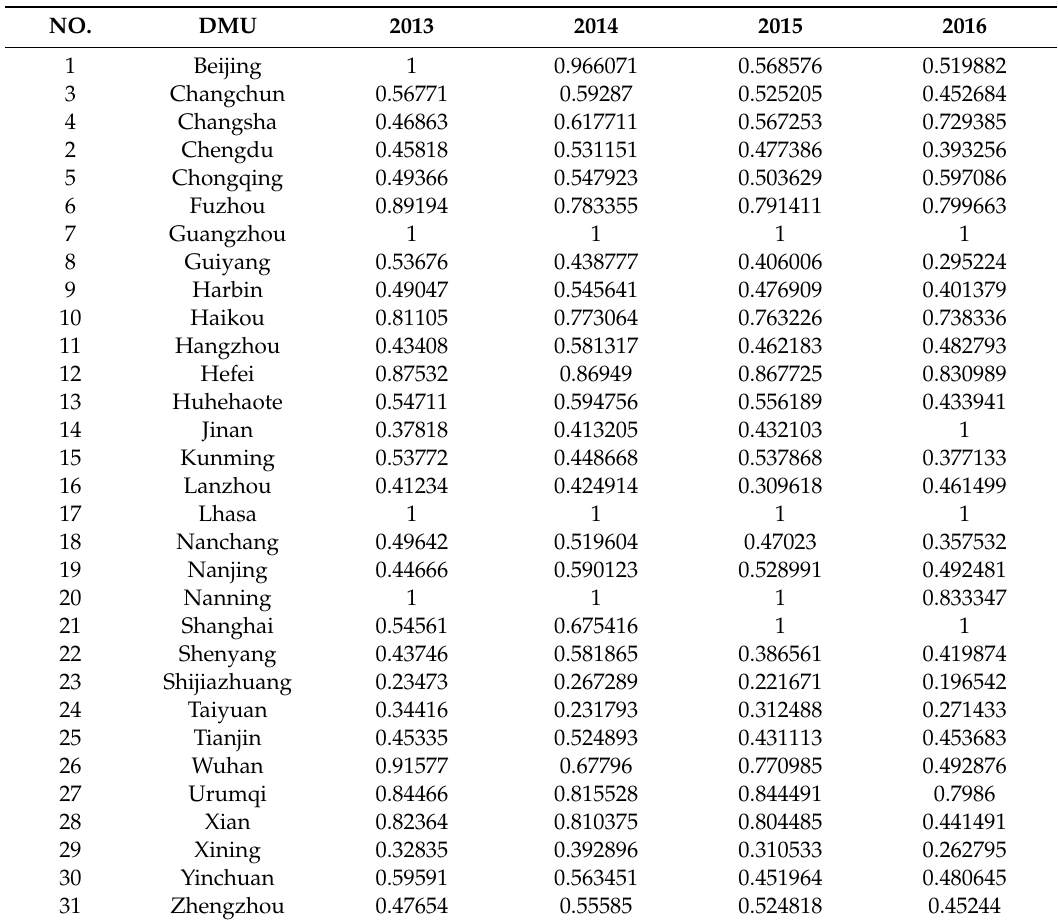
Table 3. Overall e ffi ciency by city from